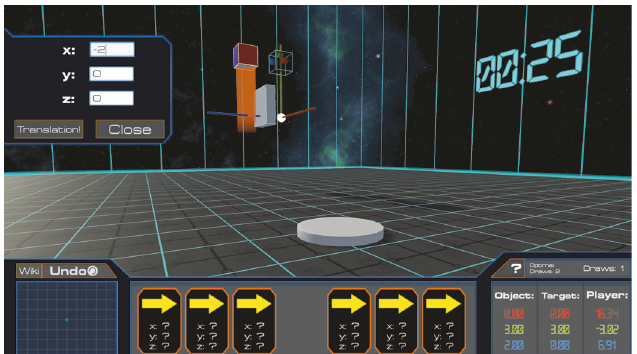
Figure 5: GEtiT challenges learners with spatial AT puzzles. The goal is to matcha level’s victory conditions symbolized by a half-transparent object (upper centerright) with the object (upper centerleft) by transforming it using the AT cards (bottom). Activating a card opens a direct value configuration screen (upper left) allowing for an input of self-obtained values. After confirming the inputs, the object gets immediately transformed and casts an orange